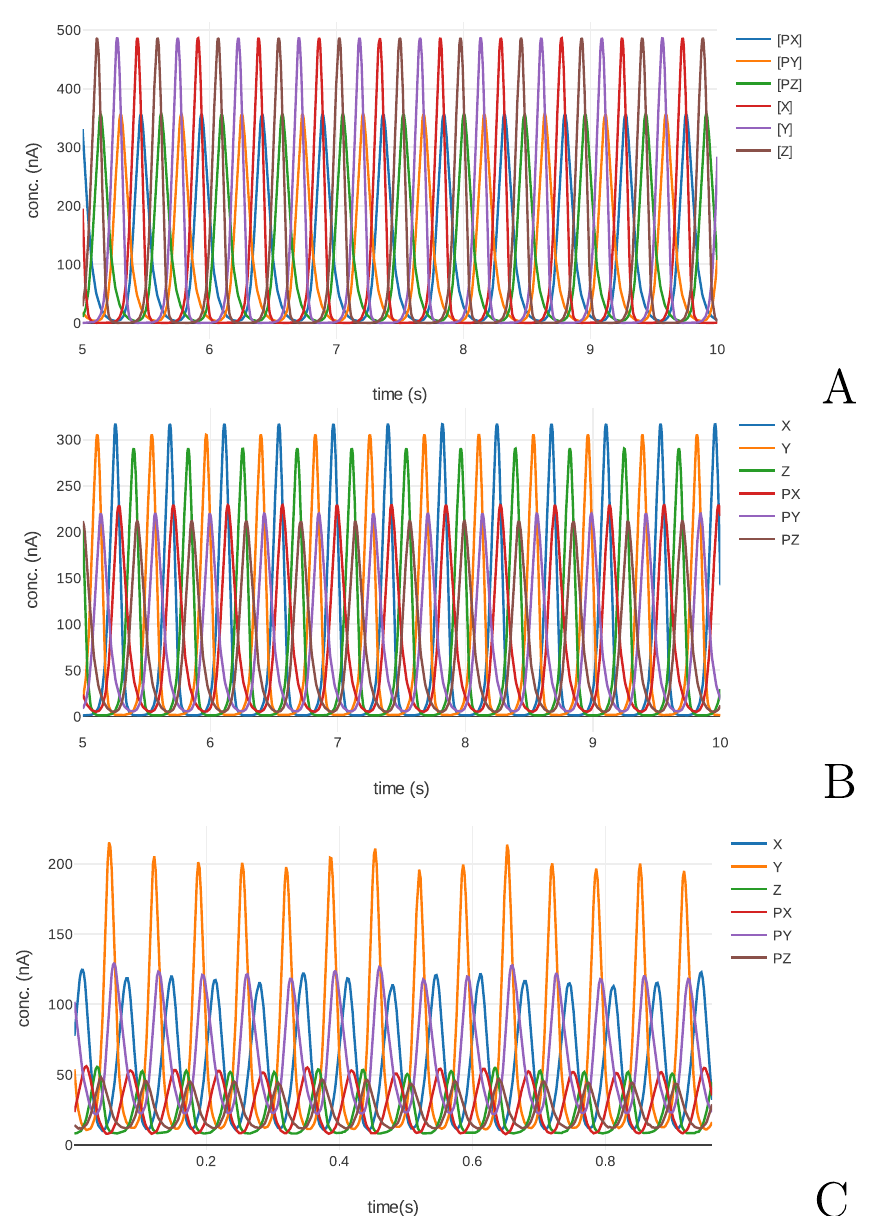
Fig 10. Comparison of repressilator model simulations. Also shown is an SBML simulation of the original model (A), a block simulation (B), and data collected from the cytomorphic chip (C). Due to manufacturing variations, blocks in the cytomorphic chip have different gains, hence the peak heights are different. The time axis on the chip data plot corresponds to “simulation time,” i.e. the actual duration of running the simulation, as opposed to “model time”, the time according to the dynamics of the model. To be useful, a hardware simulation should take less time to run than the timescale according to the model’s dynamics. This allows for multiple in silico expriments to be performed in for the amount of time a single physical experiment would take. To quantify this ratio, we performed correlation analysis on the chip data against the block simulation based on the wiring on S4 Fig (D). The cross correlation shows a peak at � 6.5 seconds, indicating a six–fold difference between model and simulation time. This does not represent a speedup over a software SBML simulation, but the cytomorphic chip exhibits constant scaling up to the maximum number of